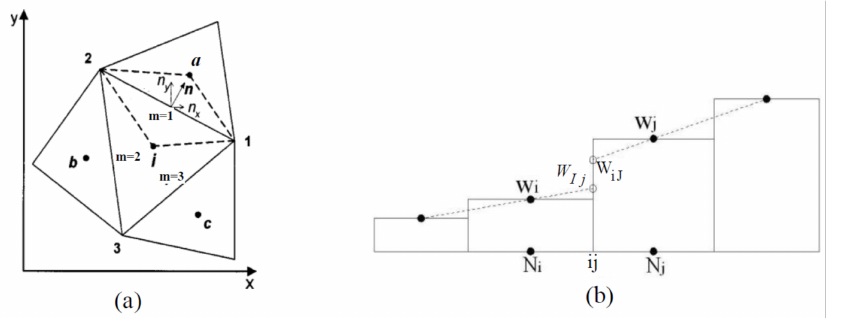
Figure 3. ( a ) A typical initial control volume cell. ( b ) Reconstruction of the conservative variables from the cell centers to the cell